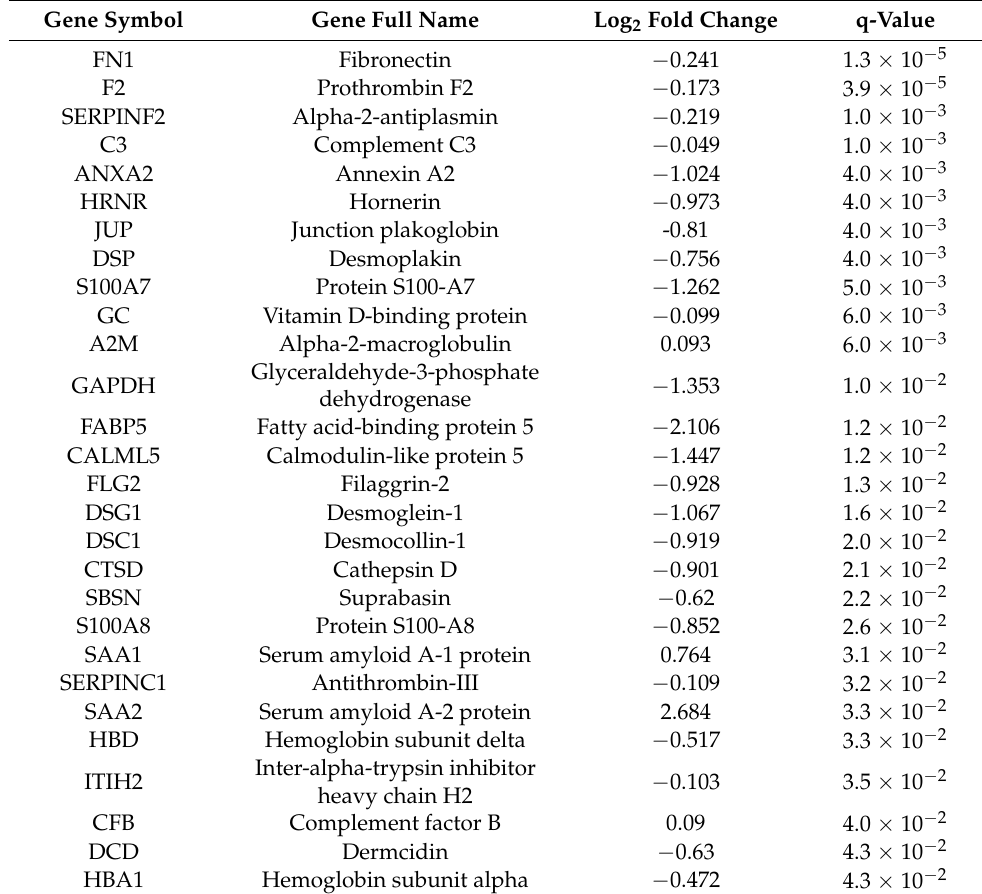
Table 1. Differentially expressed proteins in serum after 6-month treatment with teriparatide, ordered by q-value.